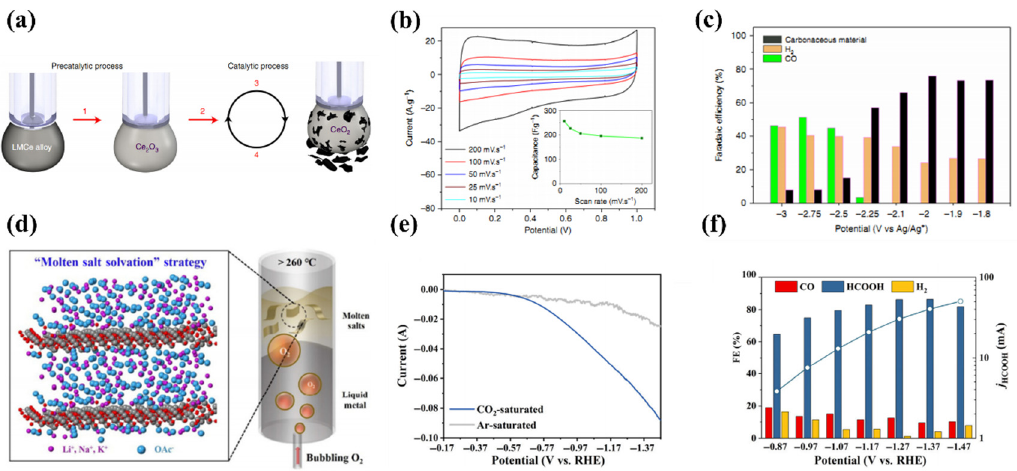
Figure 5. ( a ) Schematic of the catalytic process. The proposed process is based on operando Raman measurements, it includes pre-catalytic reactions and the catalytic cycle for the CO 2 reduction to amorphous carbon sheets ( b ) Supercapacitor behaviour of the as-prepared materials, insert image are the calculated specific capacitance of the capacitor at various scan rates ( c ) Faradaic efficiencies of LMCe3% for the production of CO, H 2 , and solid carbonaceous material at corresponding potentials measured in CO 2 saturated electrolytes. Reprinted with permission from Ref. [57] Copyright 2019 Nature Communications. ( d ) Principle for the growth and molten-salt assisted dispersion of 2D nanosheets from the liquid metal ( e ) Linear sweep voltammetry curve of SnO x nanosheets catalyst in CO 2 -saturated 0.5 M KHCO 3 aqueous solution (scan rate: 10 mV · s –1 ) ( f ) Faradaic efficiency of H 2 , CO and formate in the electrocatalytic CO 2 RR with different potentials applied to the catalyst-loaded working electrode. Reprinted with permission from Ref. [83] Copyright 2021 Nano